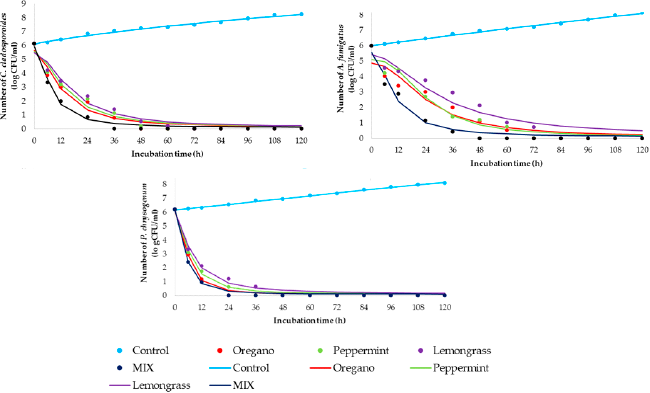
Figure 1. Time-kill kinetics study between MIC values of essential oils (markers signify the experi- mental data; lines indicate predictive results.